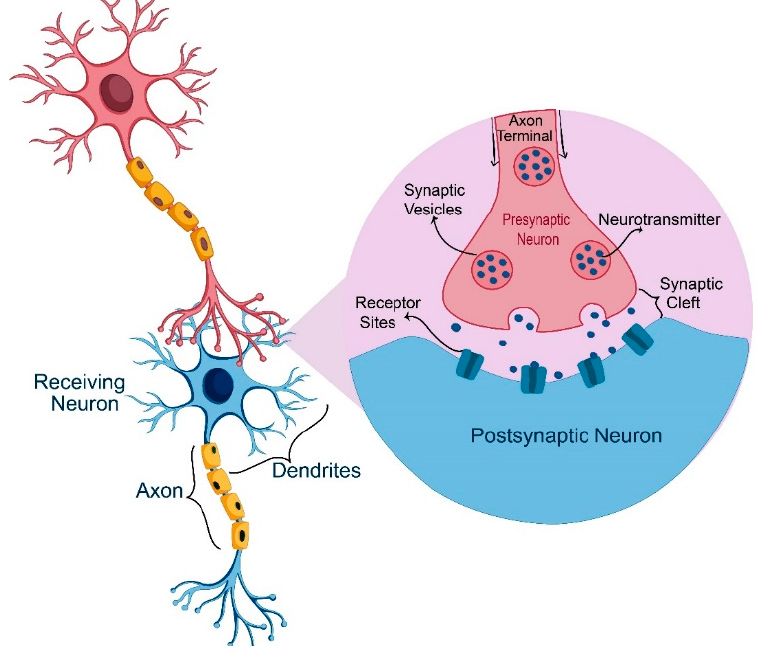
Figure 5. Neuron communication process .